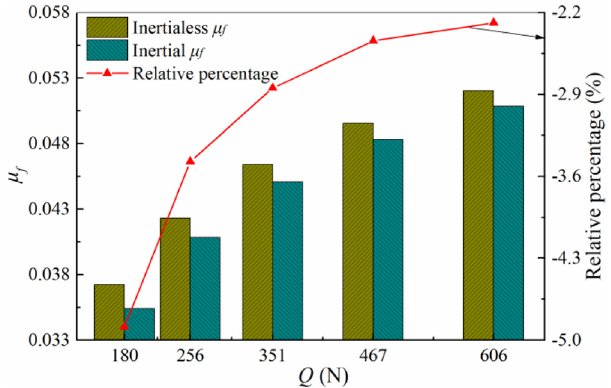
Fig. 9. Comparison between friction coef fi cient with and without inertia forces at varied applied